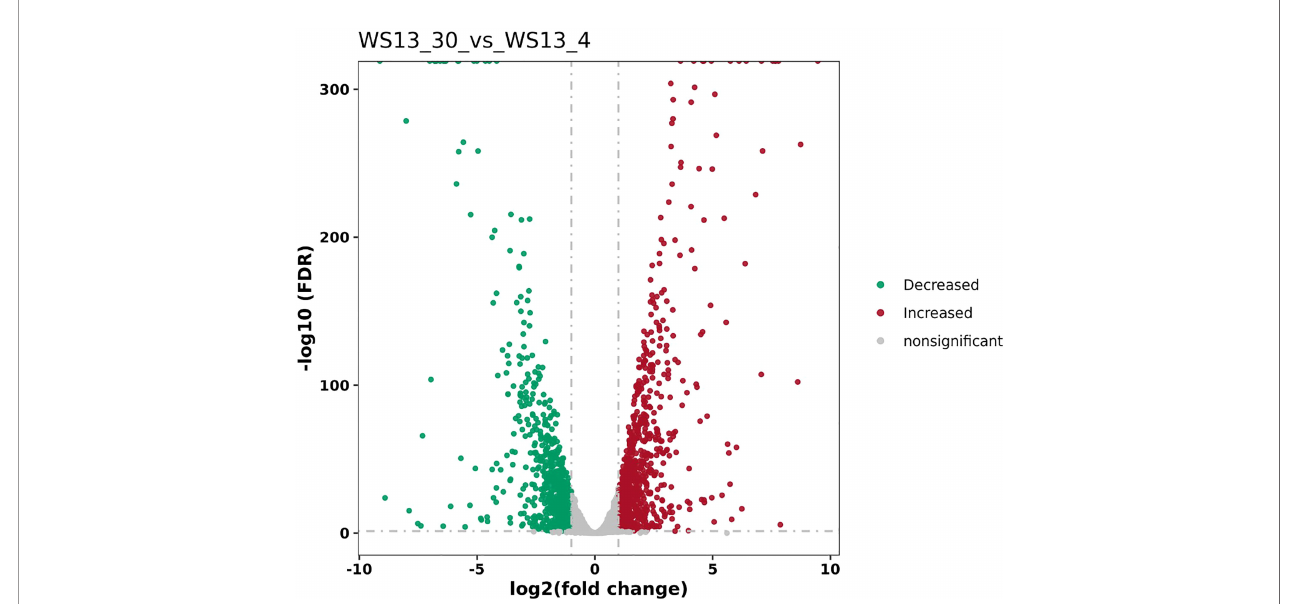
FIGURE 1 | The volcano plots of DEGs between bio fi lms formed by S. putrefaciens WS13 under 4°C and 30°C.